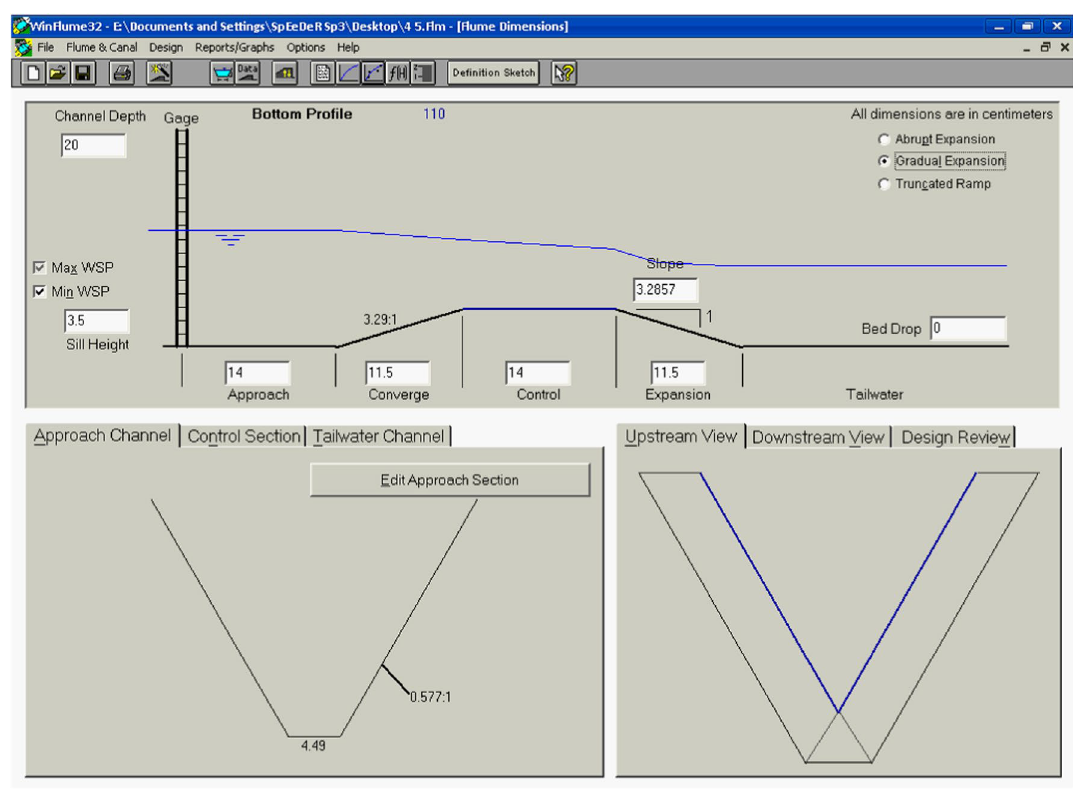
Fig. 6 Entering the length of flume sections and obtaining the simulated profile